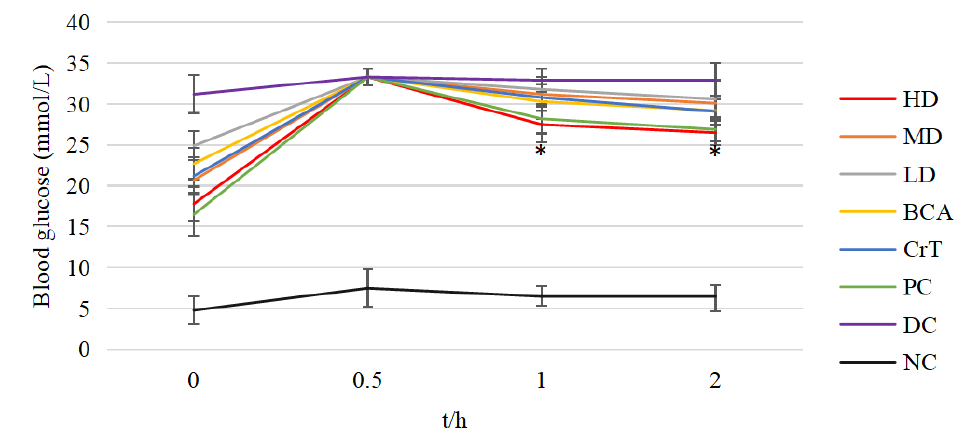
Figure 9. OGTT in each group of mice. Values are means ± SD ( n = 7). The differences between these groups and the DC group were statistically significant (denoted by “*” for p < 0.05).